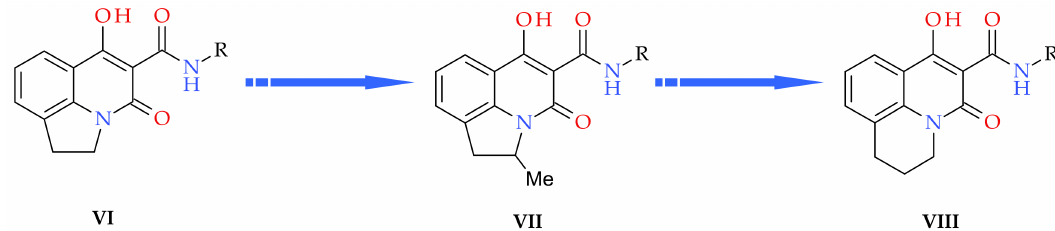
Figure 2. The chemical modification of tricyclic quinolone diuretics from pyrroloquinolines VI [24,25] to their 2-methylsubstituted analogs VII [26,27] and further to pyridoquinolines VIII